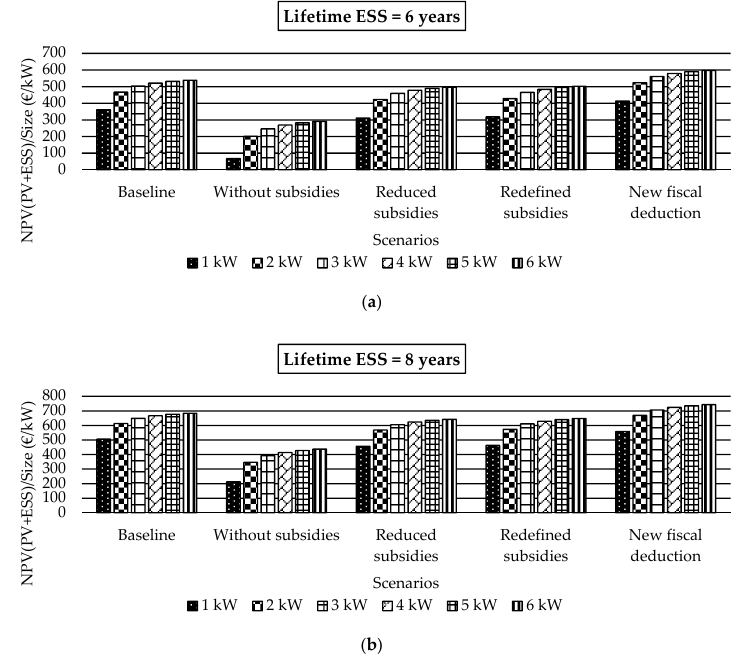
Figure 5. Net Present Value (PV + ESS)/Size (€/kW) with B/S equal to 2.0 and Δ w self,c of 40%. ( a ) lifetime EES equal to 6 years; ( b ) lifetime EES equal to 8 years.